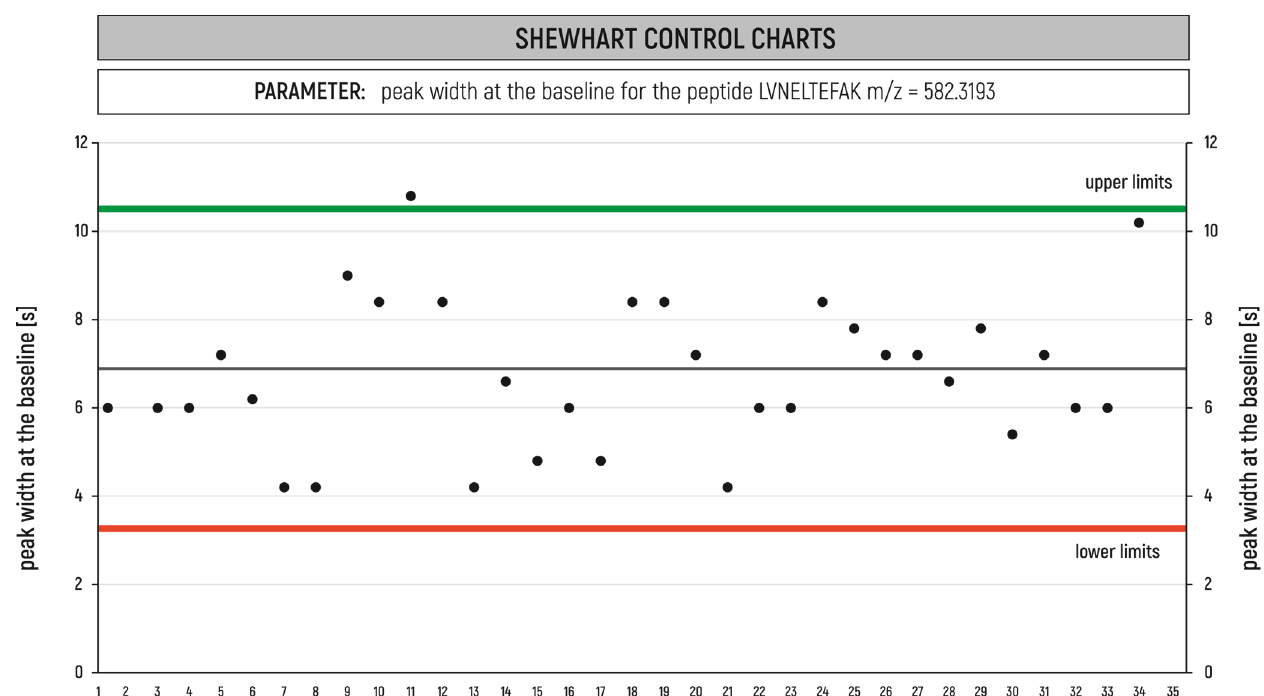
Figure 4. Shewhart charts for peak width at the baseline for the selected peptide LVNELTEFAK m/z = 582.3193 from the BSA control sample.